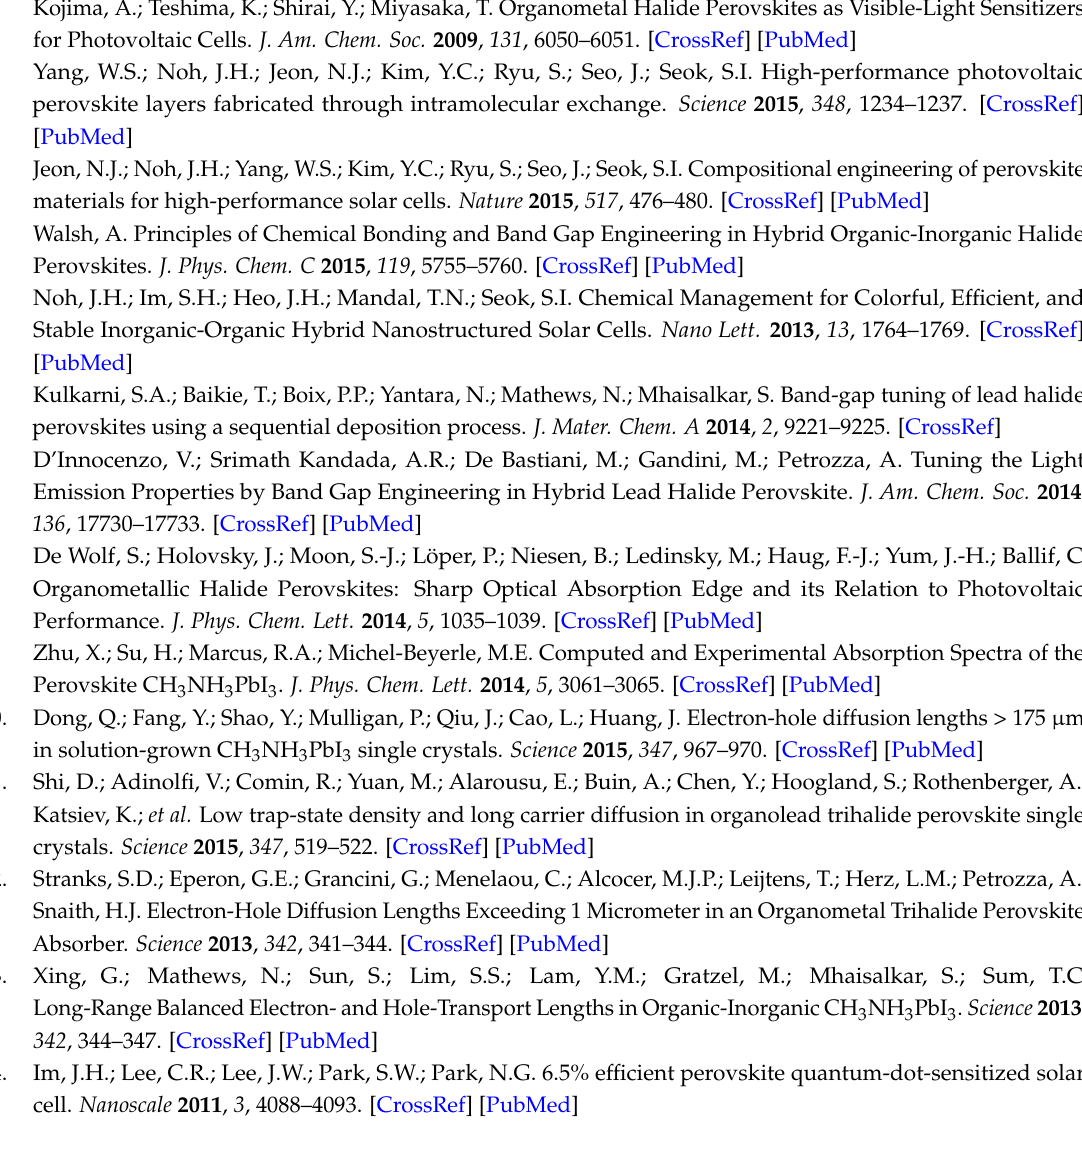
Figure S1: Ultraflat perovskite film with around 70 nm thickness deposited with the VAOS method, Figure S2: Cross-section SEM graph of PEDOT:PSS